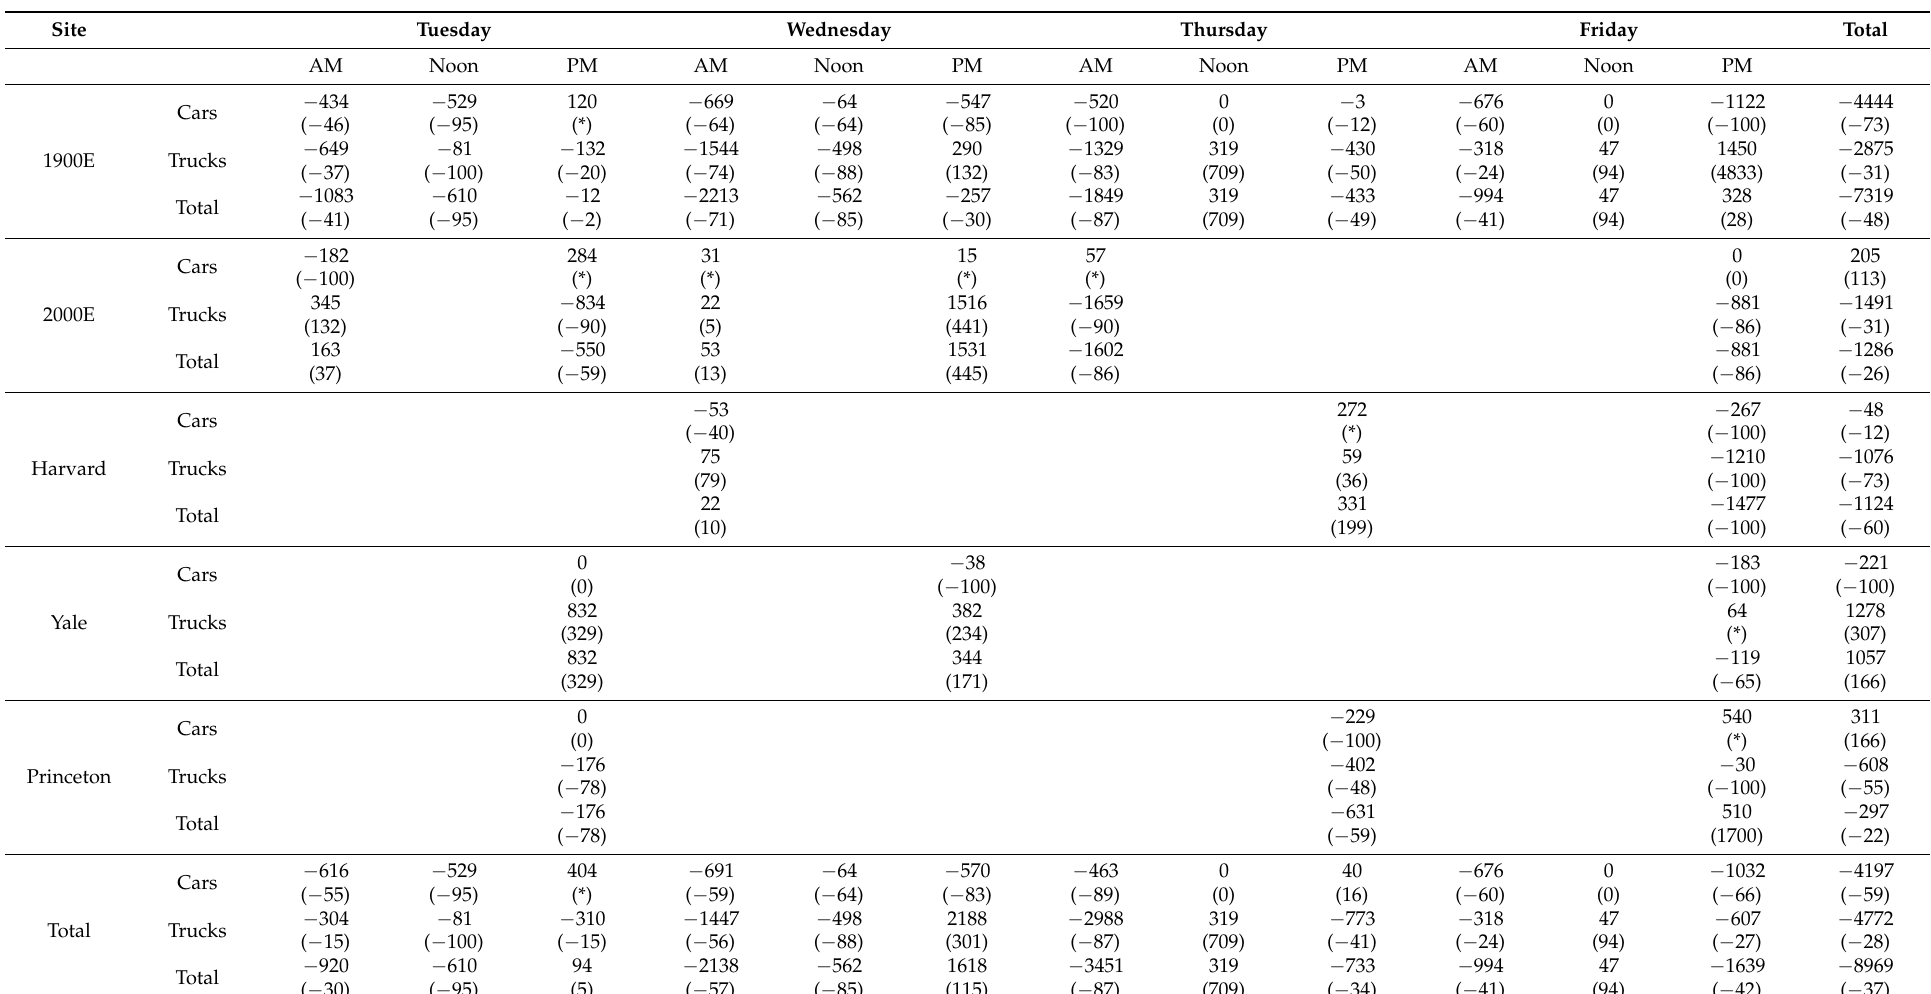
Table 11. Idling time difference in seconds (percent difference) between post-intervention week: 18–21 February 2020 and pre-intervention week: 17–20 September 2019. * denotes that there was no idling in the pre-intervention period and would have resulted in division by